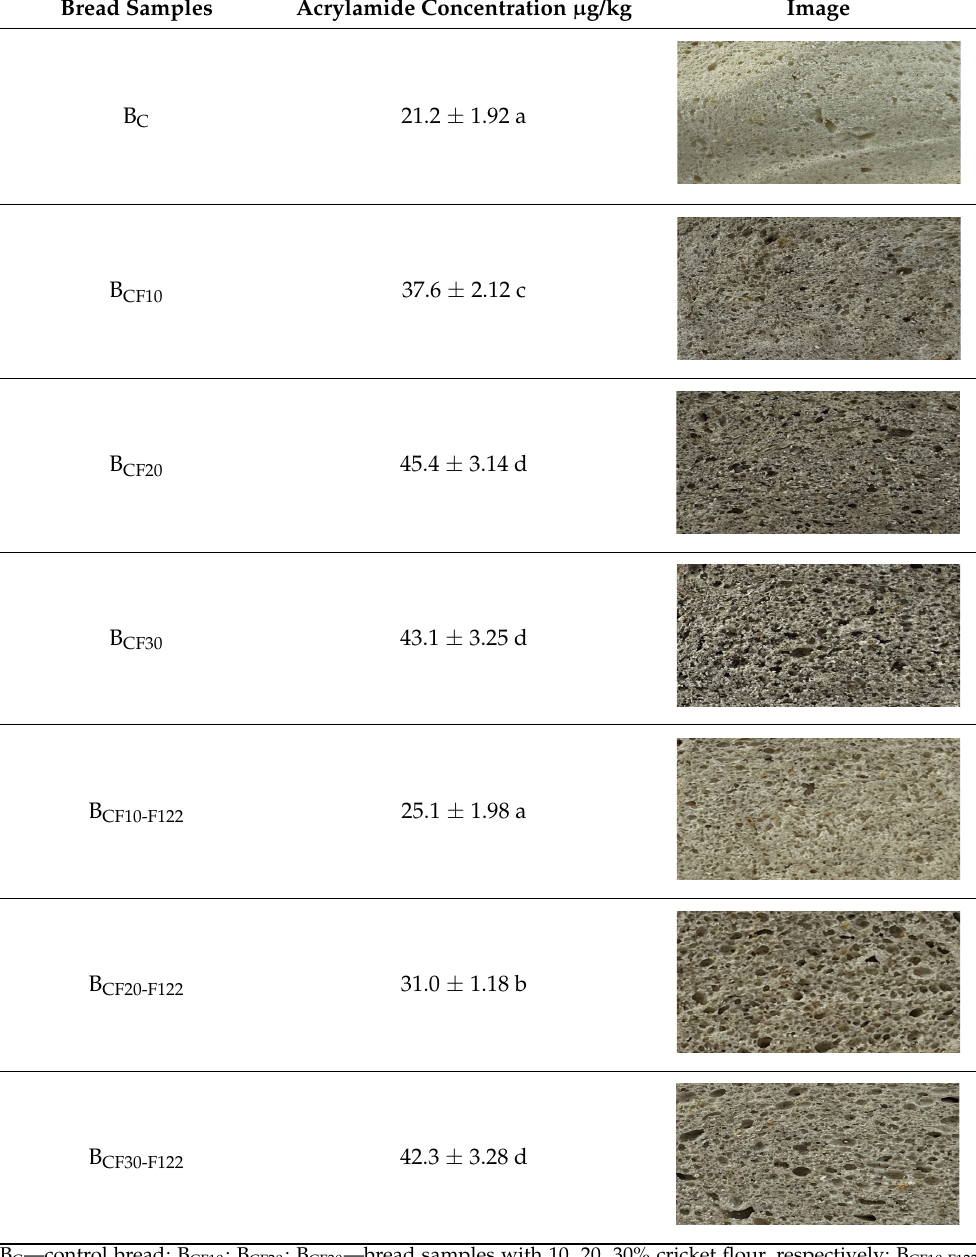
Table 8. Acrylamide concentration ( μ g/kg) in bread samples and bread crumb images. Bread Samples